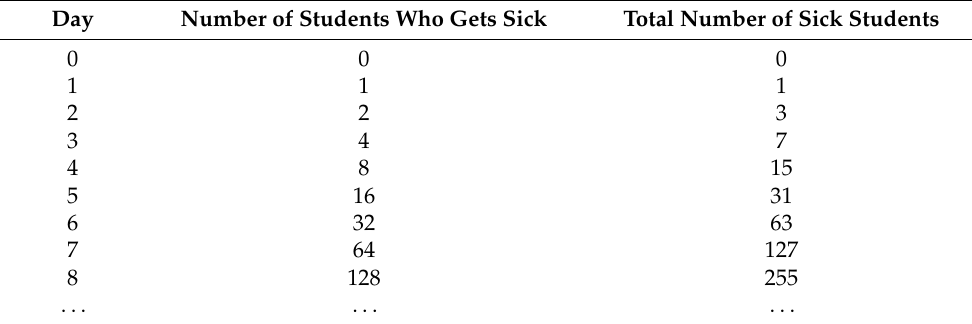
Table 9. Each student infects two